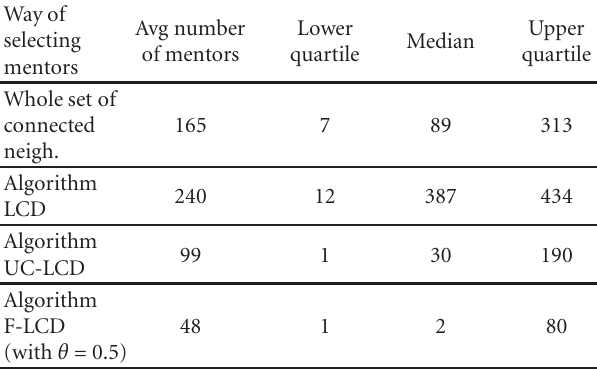
Table 1: Settingup of the communities of the MovieLens dataset.